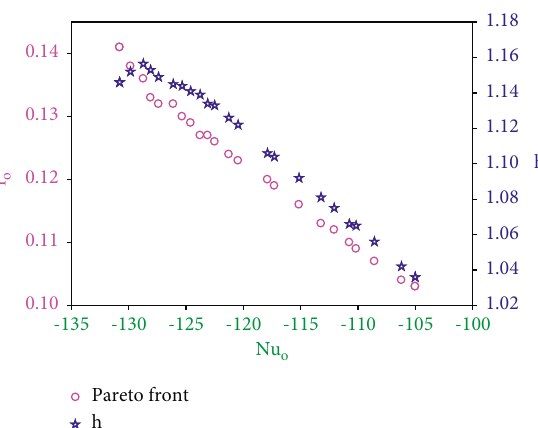
Figure 14: Multi-objective optimization of Pareto front ( η